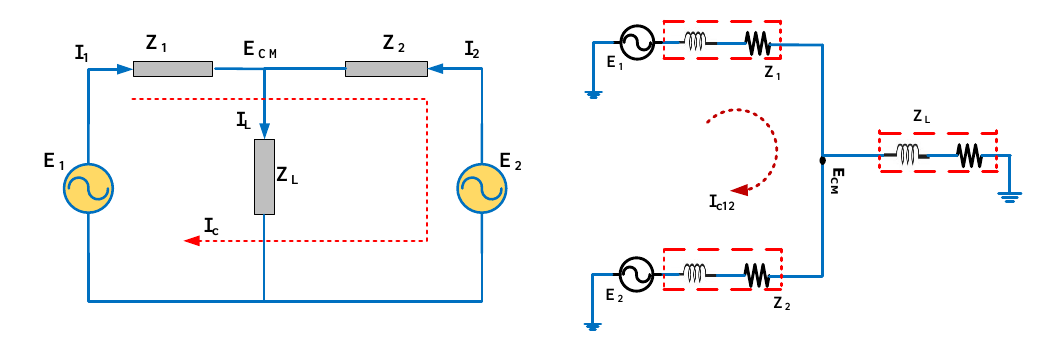
Figure 2. System model of parallel NPC inverter.